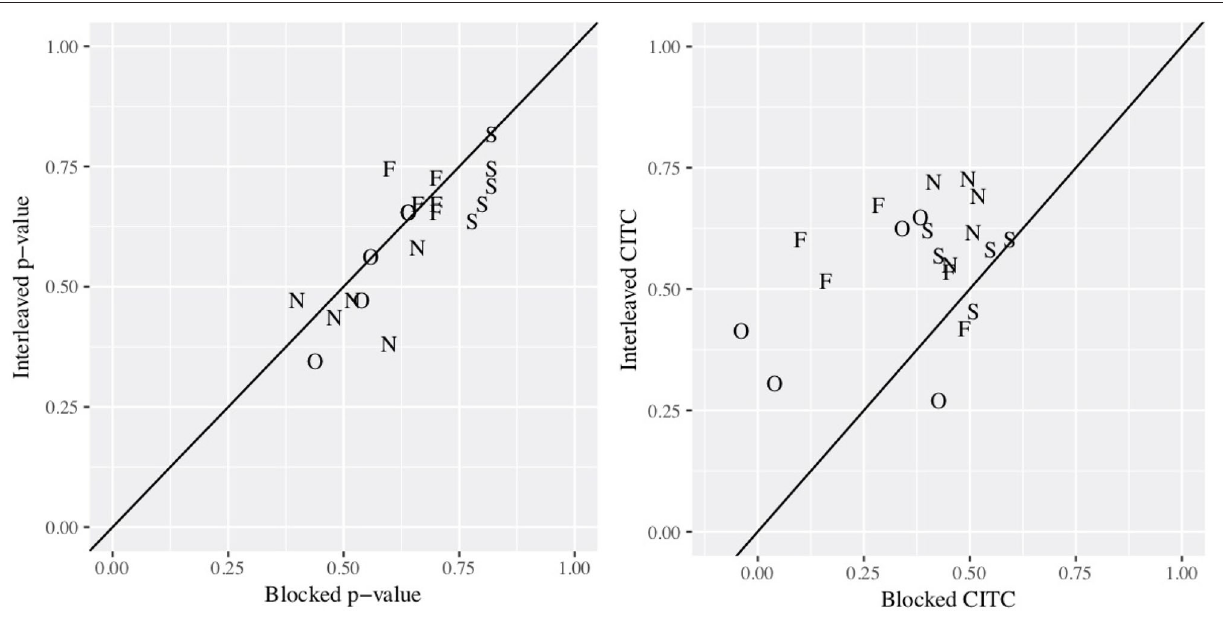
FIGURE 1 | Scatterplots comparing proportion correct ( left plot) and discrimination (right) for each item by form (blocked on the x -axis, interleaved on y ). Plotting characters represent the task for each item, abbreviated as F, O, S, and N (letter finding, orienting, selecting, and naming, respectively). TABLE 4 | Model fit